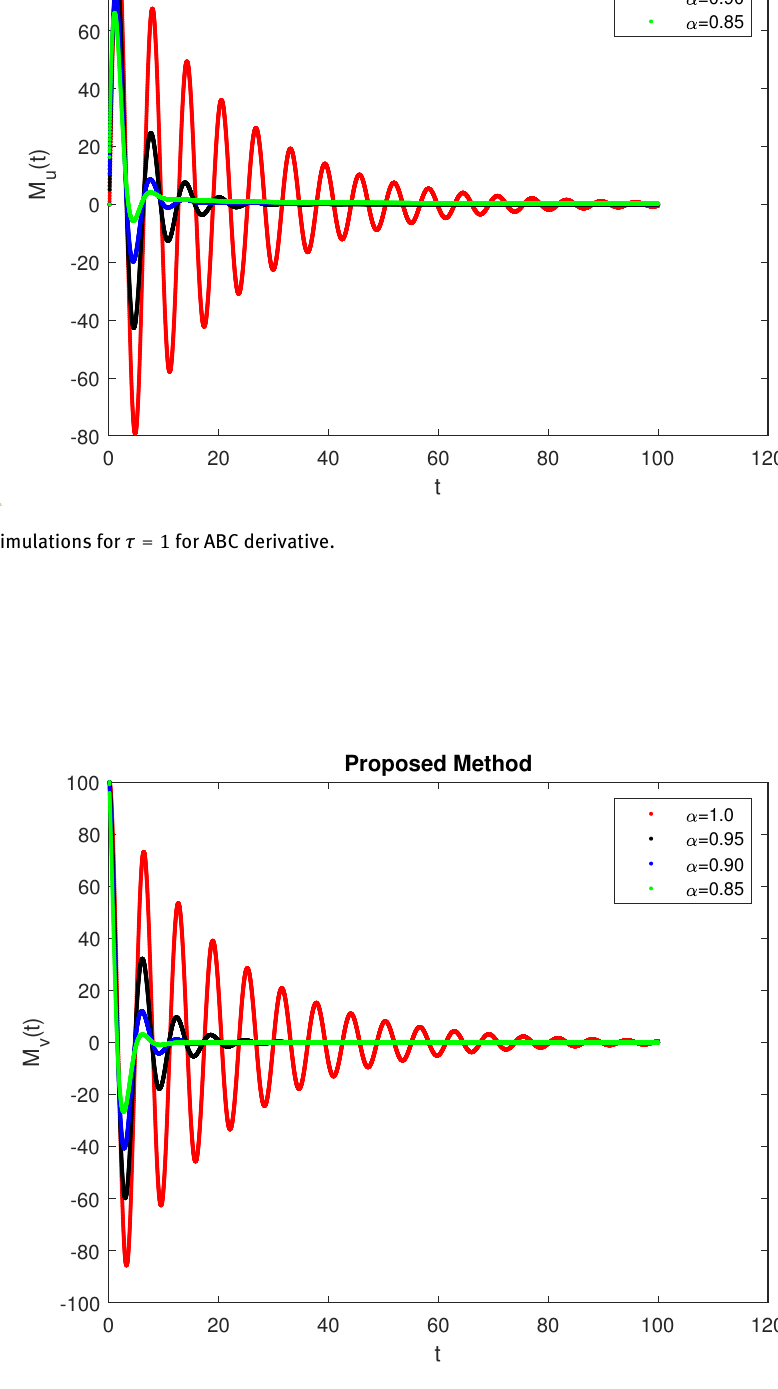
Figure 2: Numerical simulations for τ = 1 for ABC